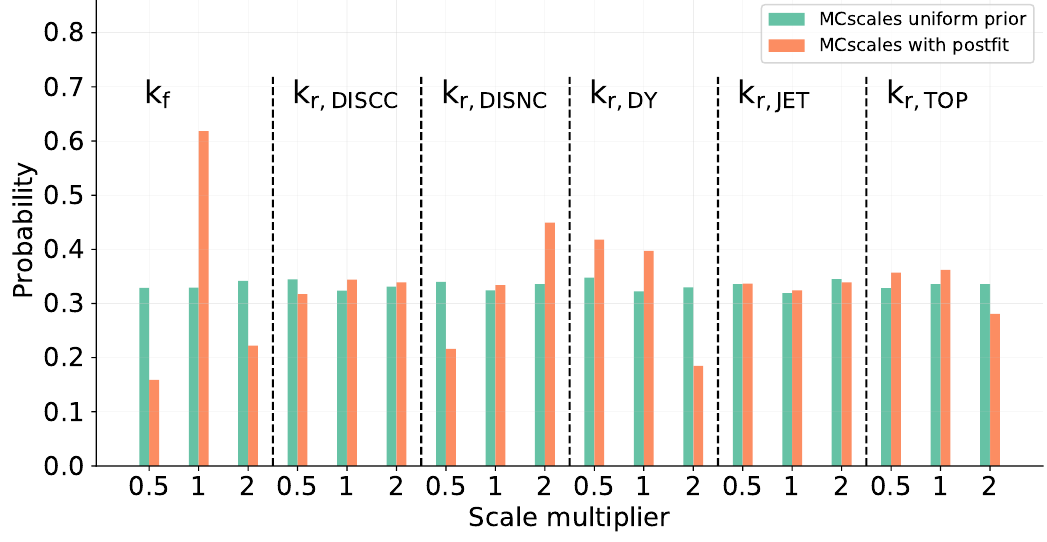
Figure 2 . The distribution of PDF replicas over each of the scales in two cases: in green for the MCscales uniform prior and in orange for the distribution after